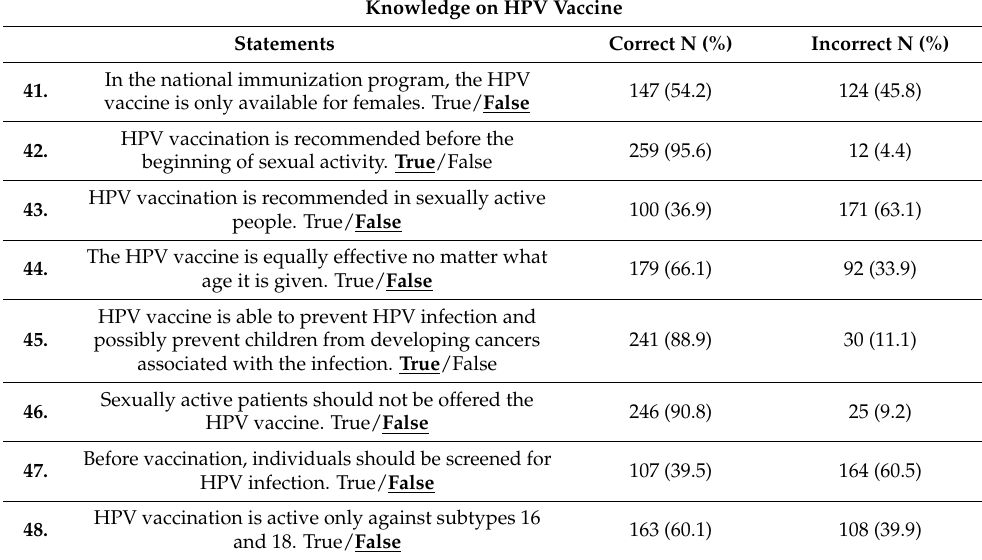
Table A4. Survey responses assessing pediatric dentists’ perception on HPV-related OP-cancer, HPV infection and HPV vaccine. Each of these statements can be answered on a five-point scale: 1.